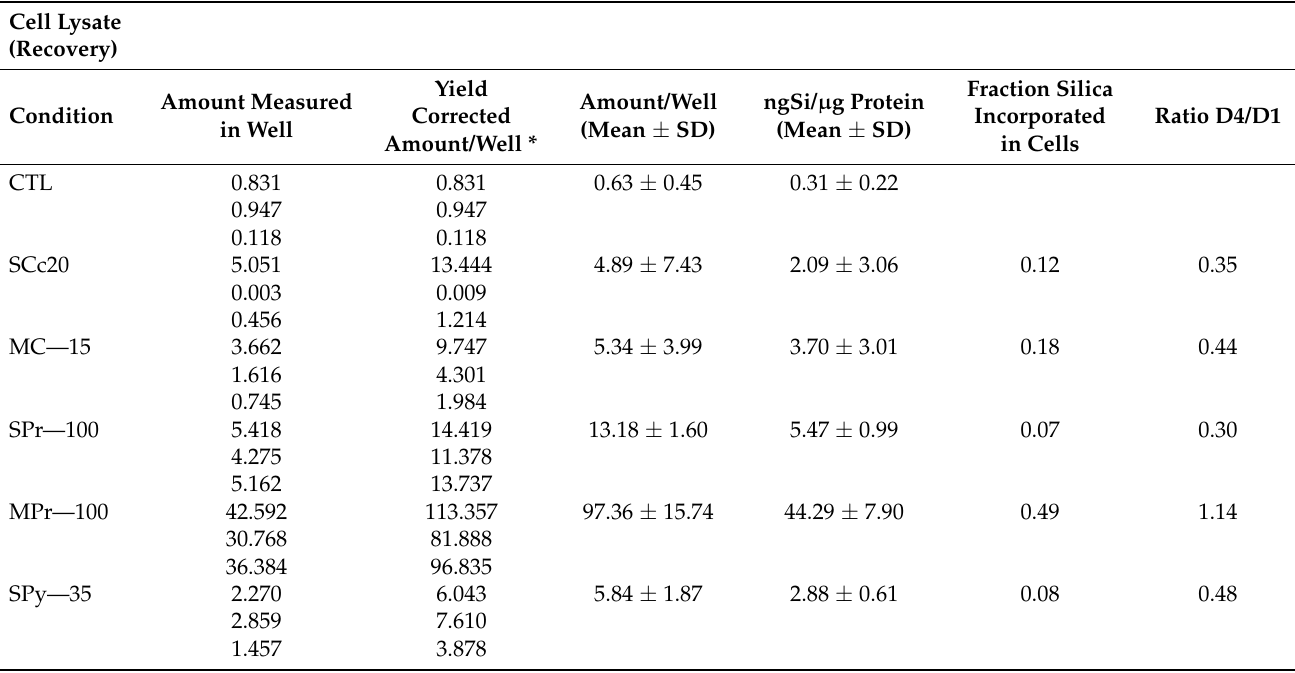
Table 3. Determination of the internalized silica in the cells, and still present after the recovery